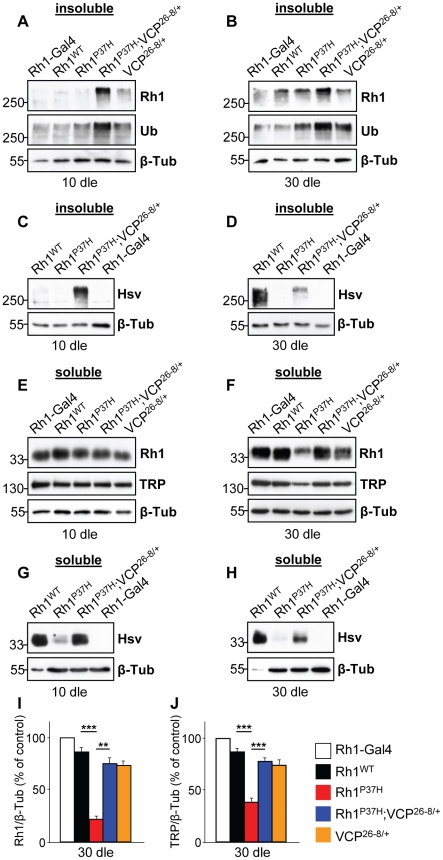
Decreasing VCP function increases Rh1 aggregate load and restores mature Rh1 levels in Rh1P37H-expressing flies.(A–D) Immunoblots showing the levels of total (A,B, endogenous and ectopic, Rh1 antibody) and ectopic (C,D, hsv antibody) Rh1 aggregates in flies of indicated genotypes after 10 (dle) (A,C) or 30 (B,D) days of light exposure (dle). An Ubiquitin-specific antibody was used to independently label aggregates. Rh1P37H;VCP26-8/+;Rh1+/+ flies display increased aggregate levels compared to the other mutant flies. (E–H) Immunoblots revealing the levels of total (E,F, endogenous and ectopic, Rh1 antibody) and ectopic (G,H, hsv antibody) mature Rh1, as well as TRP levels in flies of indicated genotypes after 10 dle (E,G) and 30 (F,H) dle. Loss of endogenous and ectopic mature Rh1 in Rh1P37H;Rh1+/+ flies is rescued in Rh1P37H;VCP26-8/+;Rh1+/+ flies. Overexpressed WT or P37H Rh1 was hsv-tagged and Rh1-Gal4 flies, lacking hsv, served as negative control for the hsv antibody. Note that 10-fold less protein was loaded for the Rh1WT;Rh1+/+ flies (G,H) and β-Tubulin (β-Tub) served as loading control. (I,J) Quantifications of Rh1 levels (I) and of TRP levels (J) in flies of indicated genotypes, after 30 dle. Values from three independent experiments were averaged (**p<0.01 and *** p<0.001 t-test).